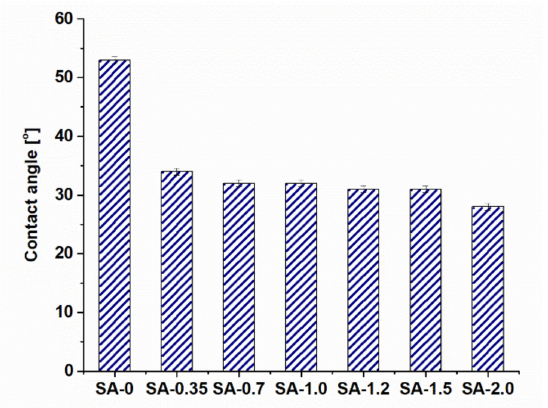
Figure 8. Correlation between water CA of the selective layer and PAA concentration in the coagula- tion